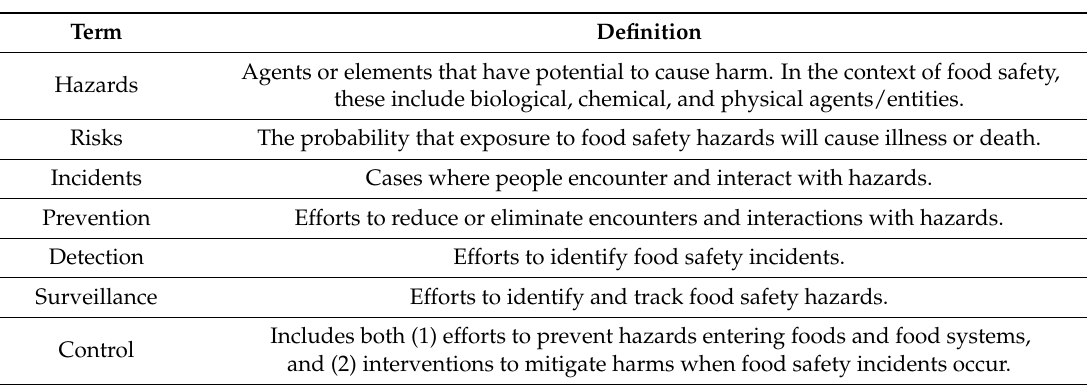
Table 1. Definitions of Selected Food Safety Systems Terms